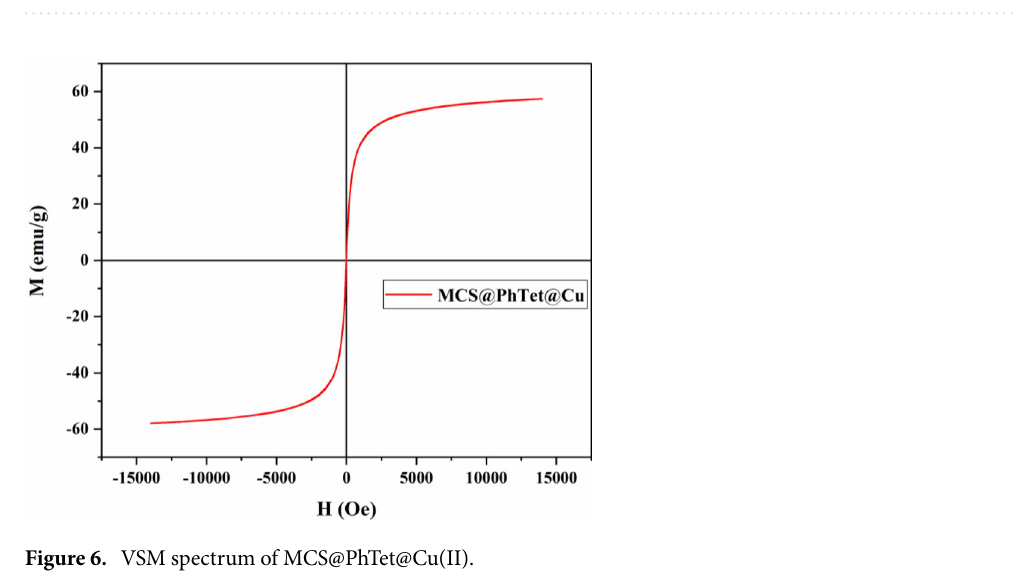
Figure 5. TEM analysis of MCS@PhTet@Cu(II).